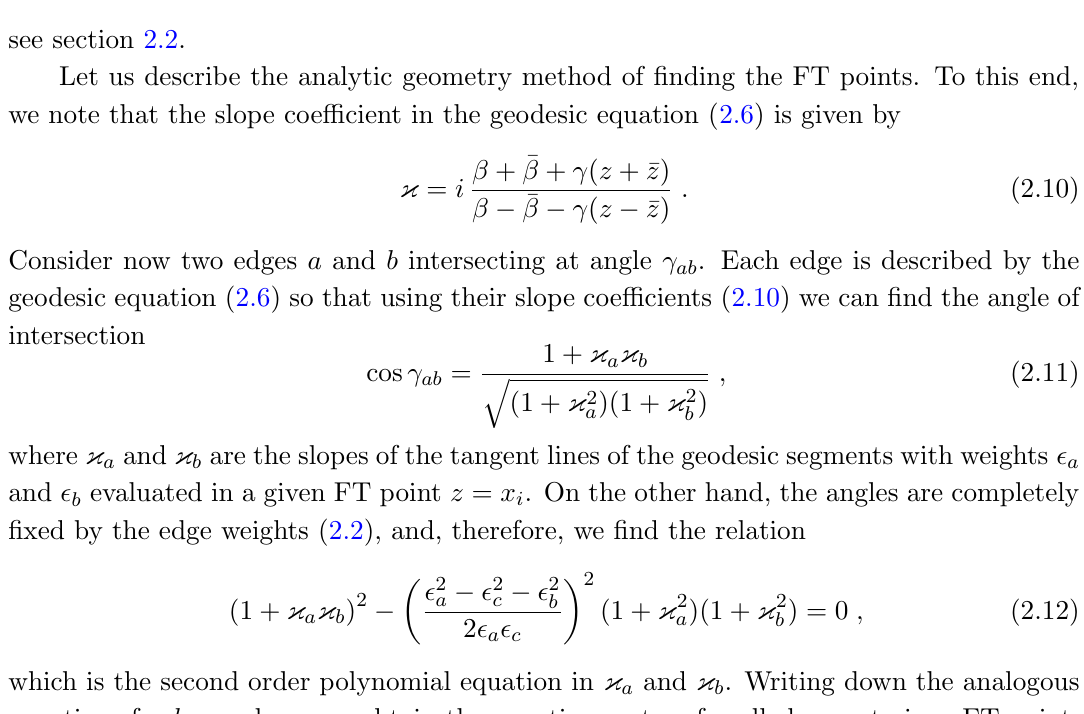
segments have di ↵ erent weights that is indicated by di ↵ erent colors.